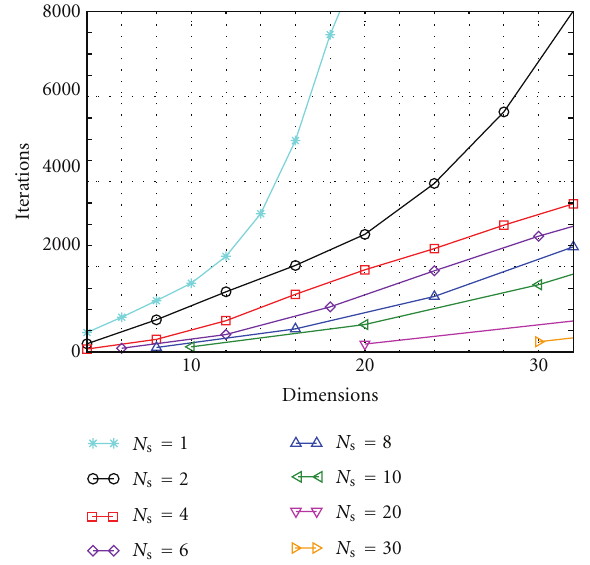
Figure 6: Required number of iterations of di ff erent swarm sizes as a function of the number of dimensions at an SNR of 10